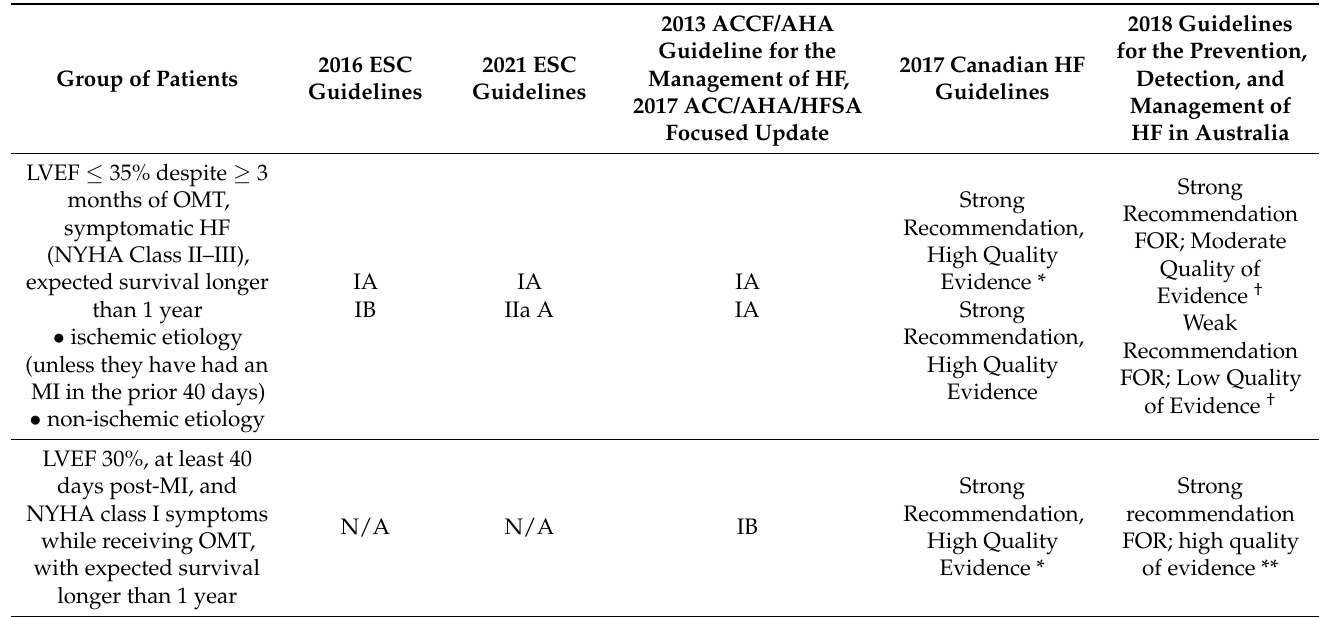
Table 1. Discrepancies between international guidelines for primary prevention of SCD-classes of recommendation and levels of